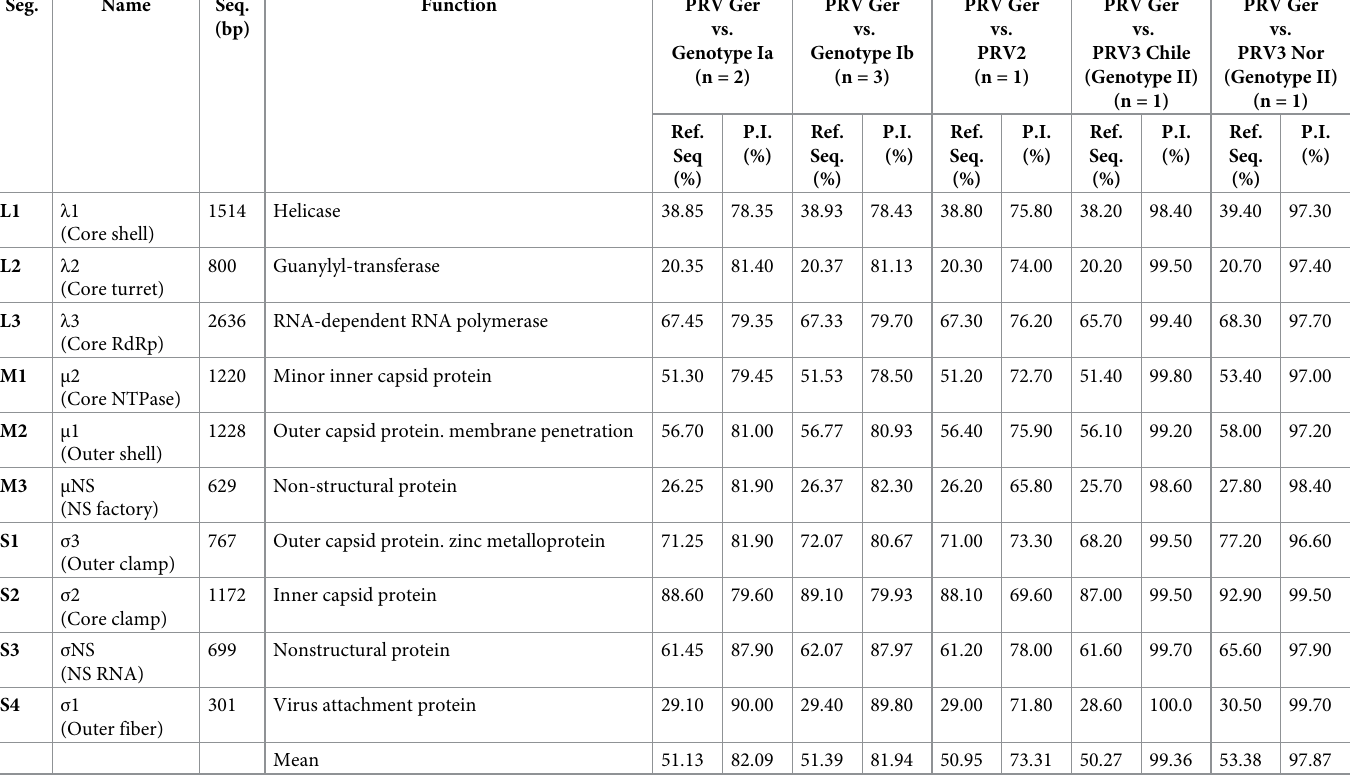
Table 1. Summary of sequenced genome segments ( λ 1, λ 2, λ 3, μ 2, μ 1, μ NS, σ 3, σ 2, σ NS and σ 1) of the virus detected in S . trutta (PRV Ger) and genetic similarity to piscine virus sequences detected in S . salar , O . mykiss and O . kisutch from Norway, Canada, Japan and Chile grouped in genotype cluster Ia, Ib, II and PRV2 accord- ing to Takano et al. [40] with additional information from GenBank entries (PRV3); Segment (Seg.), name of the segment (Name), fragment length in base pairs of the segments sequenced in this study (Seq. (bp)), segment function, sequence coverage of segments (in percent) (Ref. Seq.), and pairwise identity of sequenced frag- ment and corresponding reference sequence (P.I.). Segment IDs were assigned according to the nomenclature used by Palacios et al. (2010) [37]. (Accession numbers of reference segments are given in S2 Table).